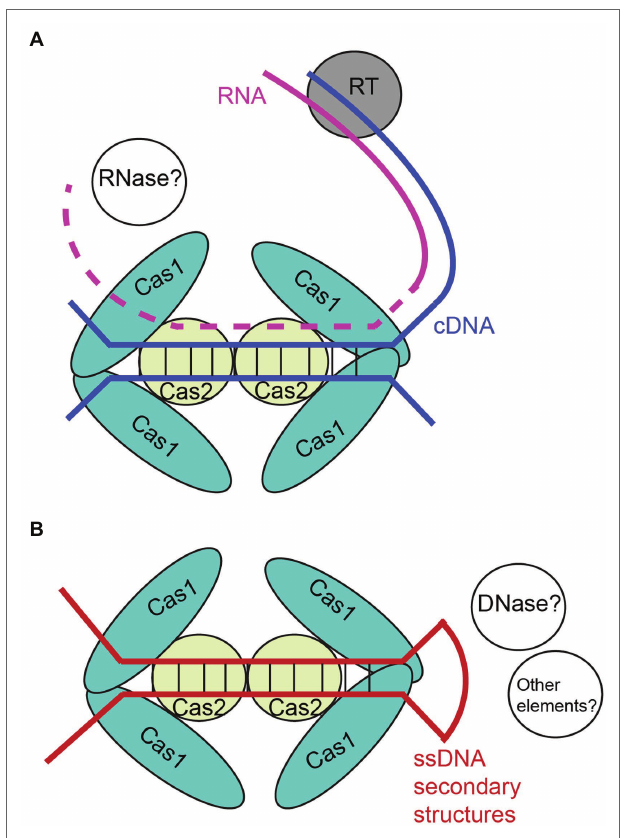
FIGURE 1 | Diagrams of unique type III adaptation preference with (A) and without (B) reverse transcriptase activity. (A) RT represents reverse transcriptase, which is usually fused with Cas1–Cas2 complex, and may also be independent as well. Complementary DNA (cDNA) is depicted by blue. RNA template is depicted by pink, and the dashed lines represents potential digestion against the RNA template. (B) Single-stranded DNA (ssDNA) secondary structure is depicted by red. Hypothetical proteins or other elements are presented by white